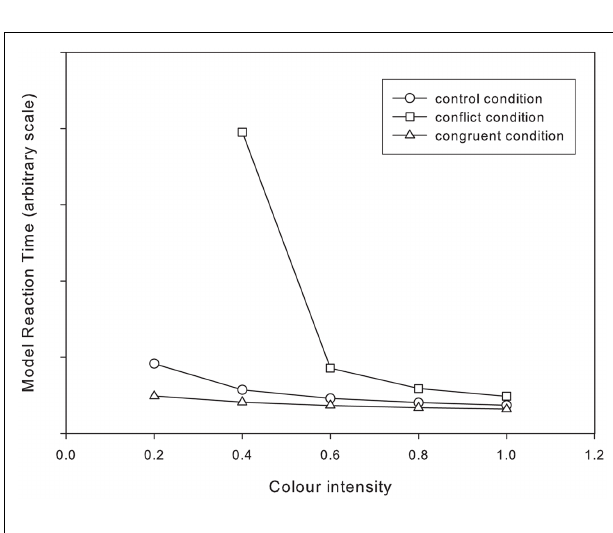
FIGURE 4 | Single stage model with unlocked inputs: simulated reaction times for the standard Stroop task across a range of color intensities. Data point omitted where model provides the incorrect response (see